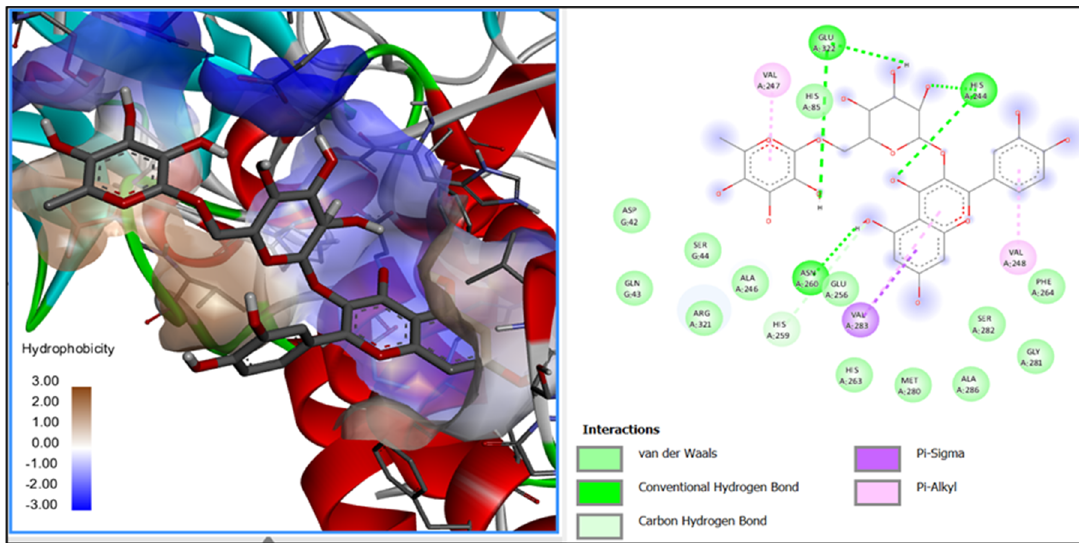
Figure 5. Molecular docking diagram for rutin interaction with the catalytic site of tyrosinase. Results represent the mean ± SD of at least two independent experiments.